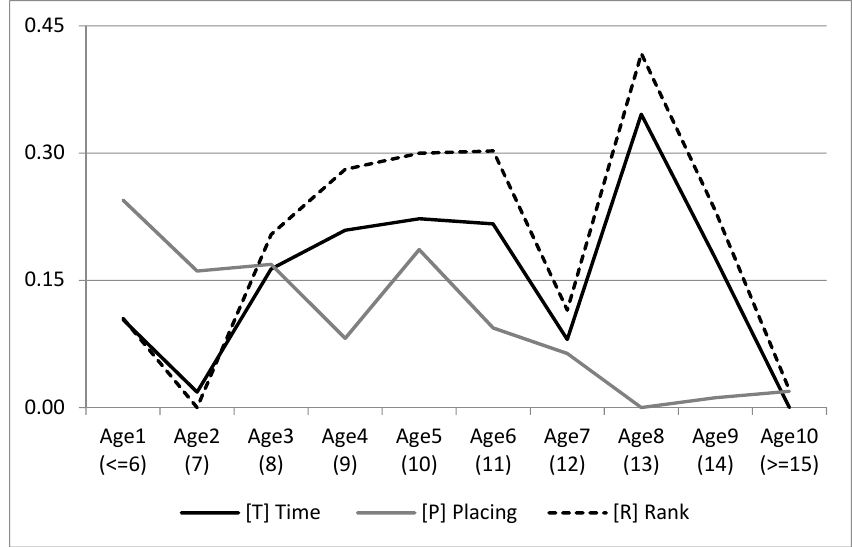
Figure 4. Means of the marginal posterior distributions for the levels of age for Race Time, Placing and Rank traits, transformed to positive scale, with the minimum set to 0.